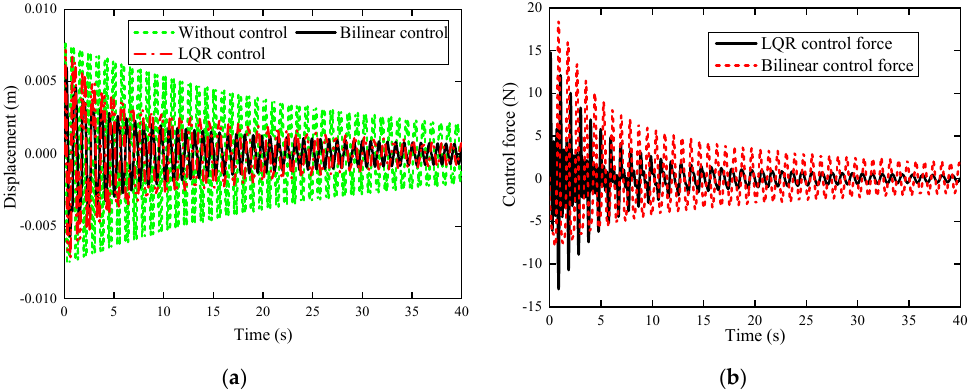
Figure 2. Time history of displacement and control force at the mid-span under free vibration. ( a ) Time history of the mid-span displacement. ( b ) Time history of control force.